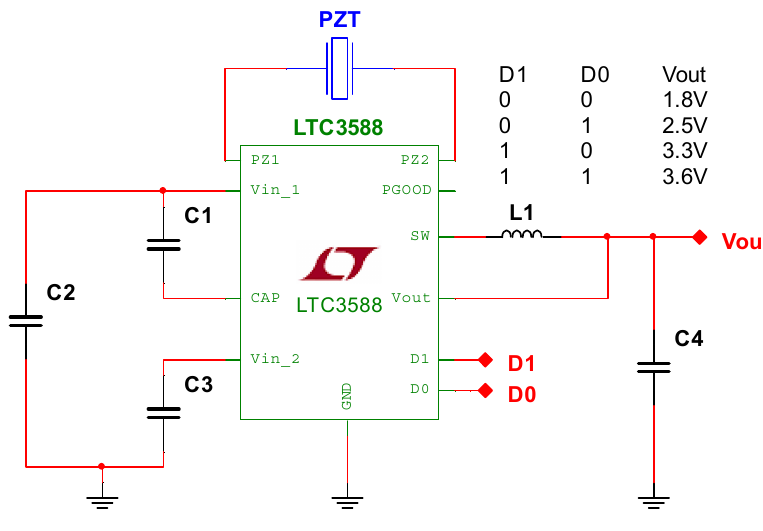
Figure 8. Integrated circuit LTC-3588.